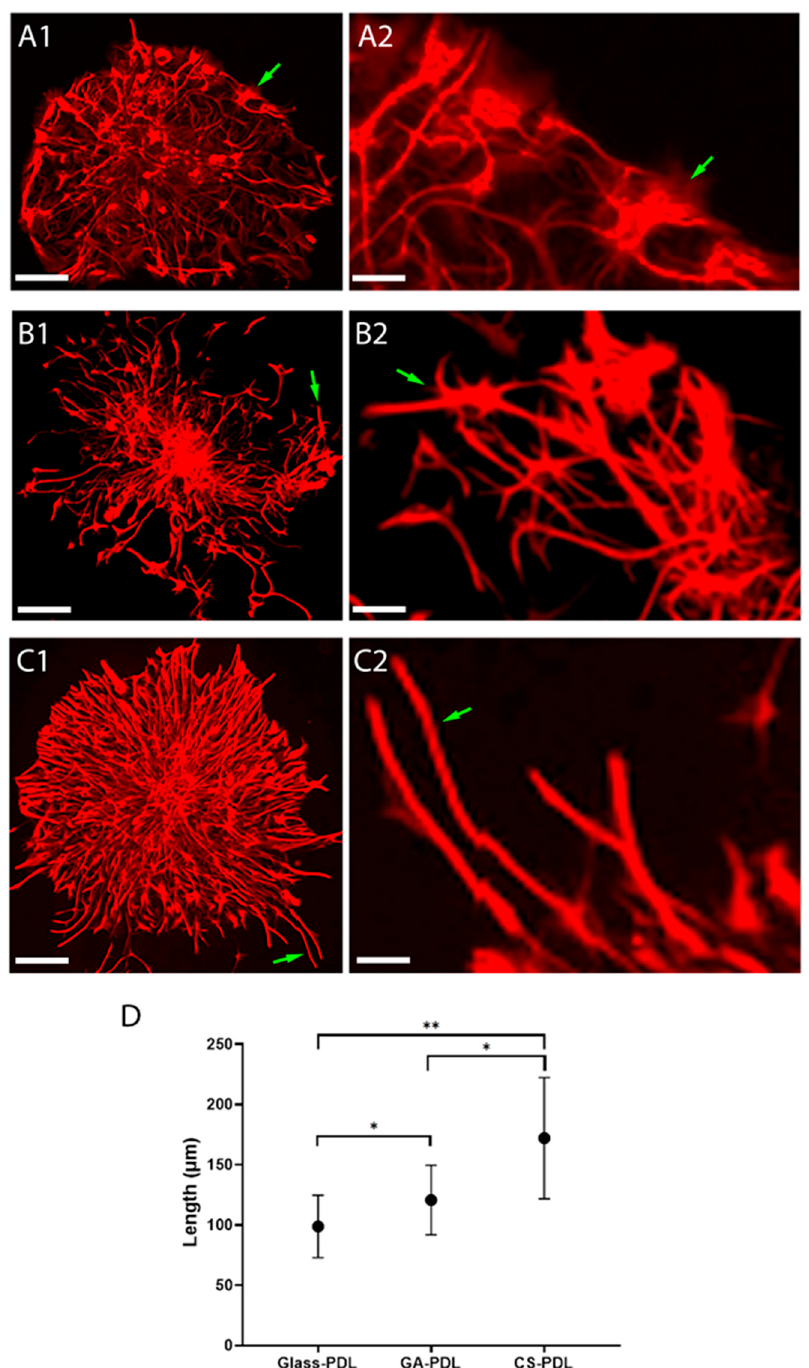
Figure 4. CS-PDL promotes elongation of astrocytic processes more robustly as compared to GA-PDL. GFAP immunofluorescence. ( A1 , A2 ) glass-PDL. Green arrows indicate flat astrocytes. ( B1 , B2 ) GA-PDL. ( C1 , C2 ) CA-PDL. Green arrows in both indicate spiky astrocytes. ( D ) Maximal length of processes. Pearson correlation: N = 91, r = 0.634, P < 0.001. Scale : ( A1 – C1 ) 60 mm; ( A2 – C2 ) 15 mm. ( D ) Mean extension length of astrocytes (glial fibrillary acidic protein (GFAP)) in different slides. Mann–Whitney U-test: Glass-PDL N = 31, Mean = 98.93 ± 25.94, GA-PDL N = 29, Mean = 120.85 ± 28.80, Z = − 2.729, P = 0.006, CS-PDL N = 31, Mean = 172.06 ± 50.24, Z = − 3.942, P < 0.001. Pearson correlation: N = 91, r = 0.634, P < 0.001. GA-PDL vs. CS-PDL: Z = − 3.942, P < 0.001. * P < 0.05; ** P < 0.01.